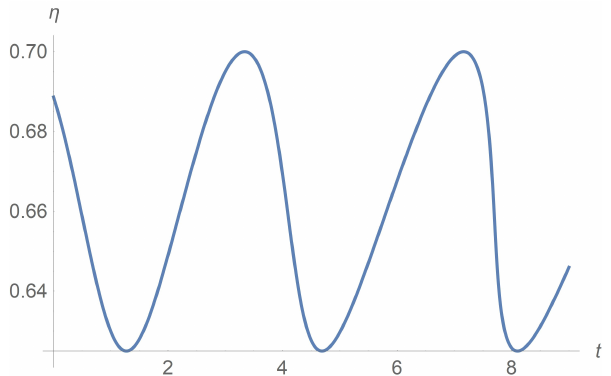
Figure 9. Apparent viscosity versus time. The case Π = Π 0 =